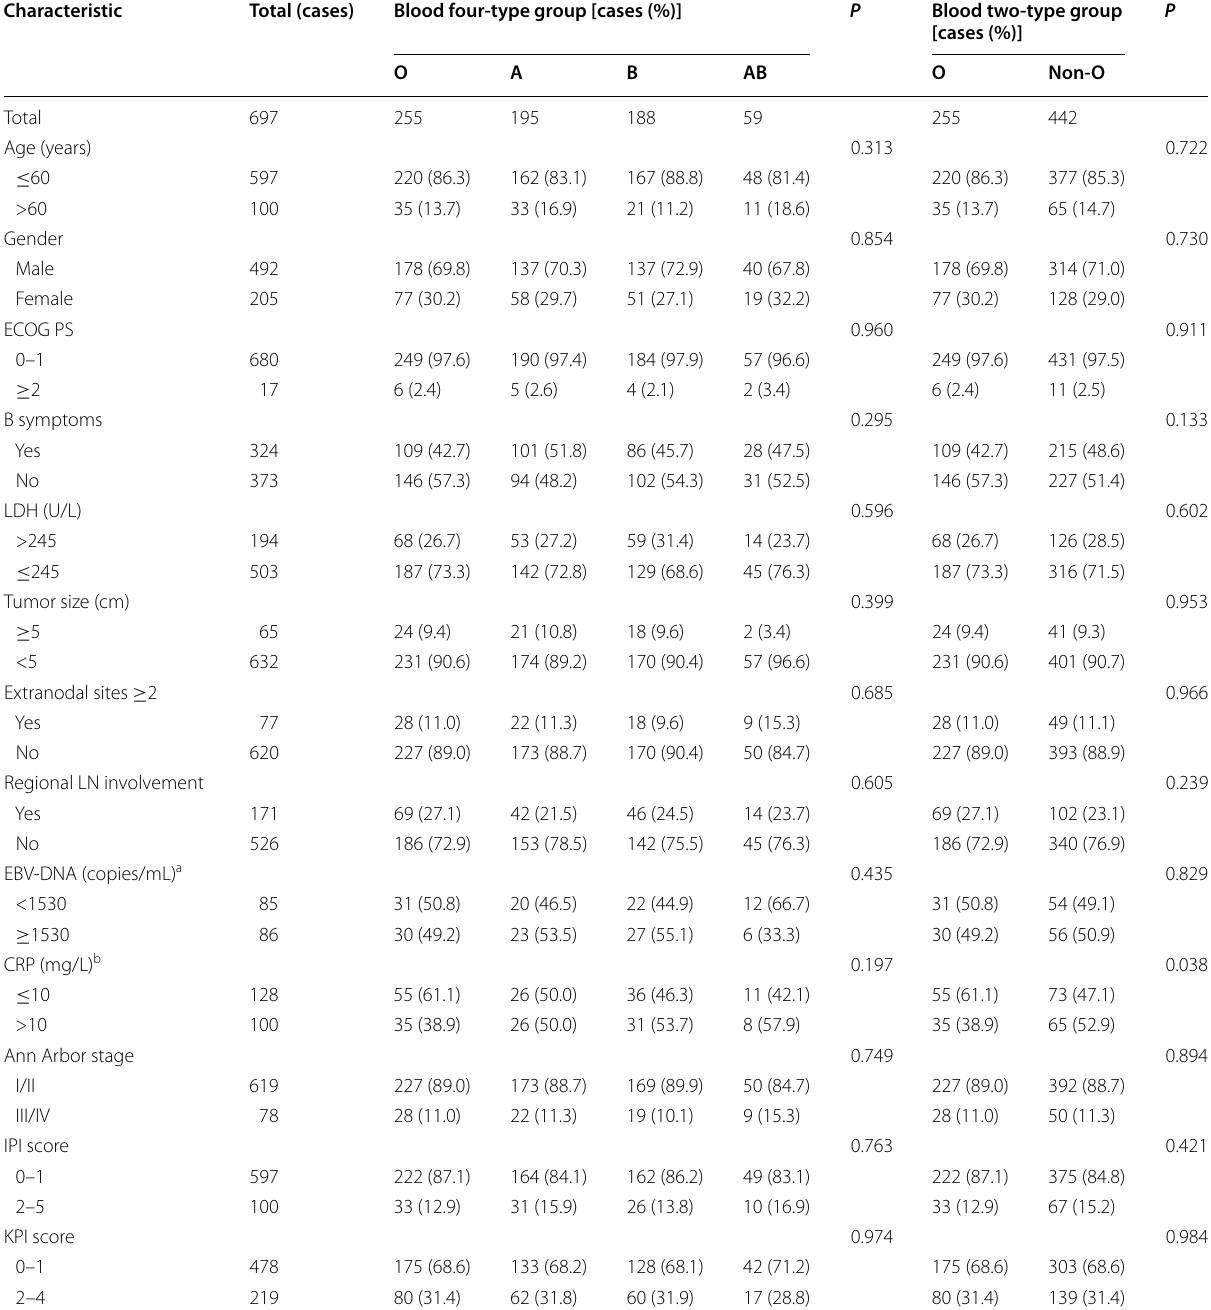
Table 1 Basic characteristics of patients with extranodal natural killer (NK)/T-cell lymphoma (ENKTL) in distinct ABO blood type